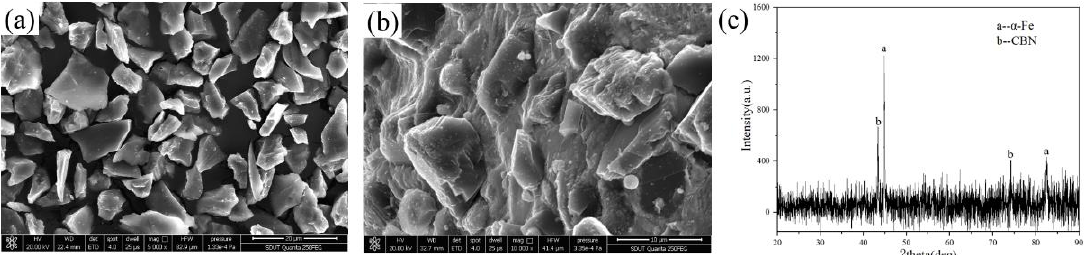
Figure 3. SEM micrographs of CBN particles ( a ) before atomization; ( b ) after atomization; ( c ) XRD and phase identification for MAPs.